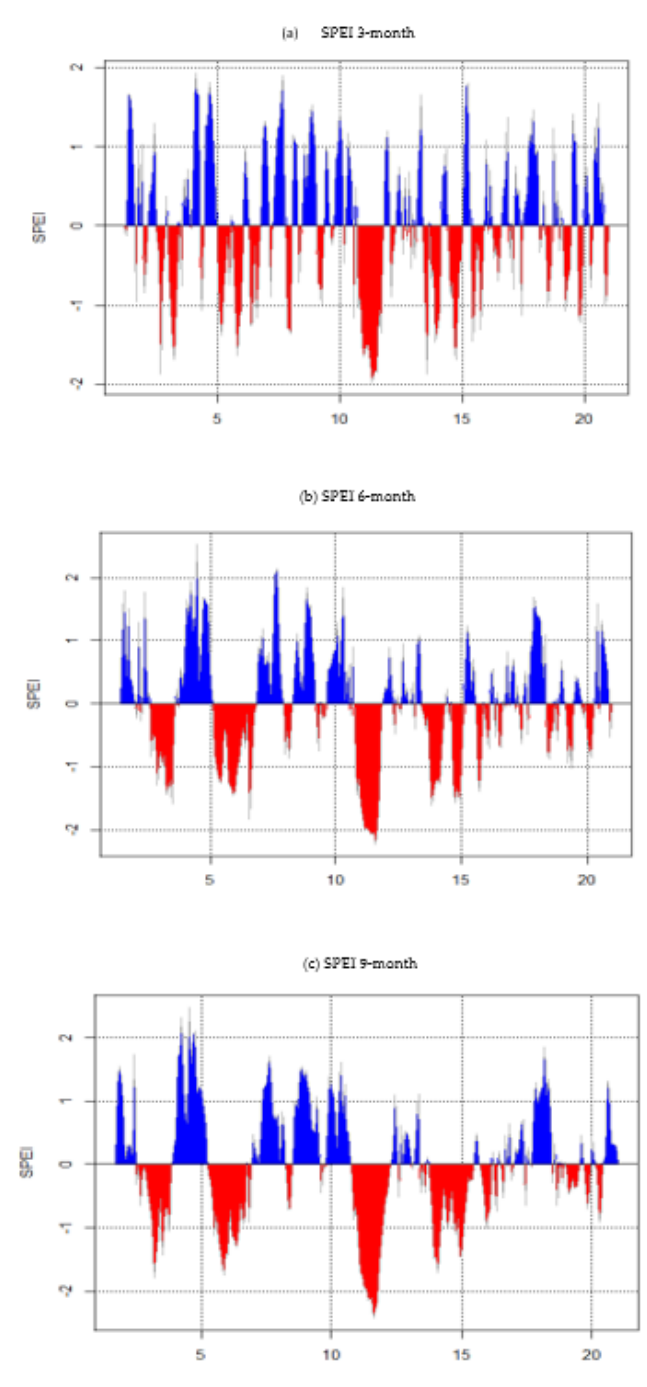
Figure 6. SPEI 3-month, SPEI 6-month, SPEI 9-month between 2000 and 2019. Dry and wet periods roughly coincide with SPI, according to SPEI findings from 2000 to 2019. The SPEI value, on the other hand, appears to be lower, indicating that the degree of extremes discovered is lower than that of the SPI. As a result, it is also essential to con- template about the possibility of modifying the SPEI threshold. damage due to drought. Yet, Ca Mau was the province which suffered the worst damage. and the Mekong